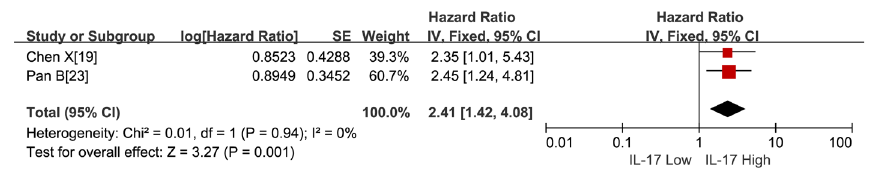
Fig 4. Meta-analysis comparing IL-17 expression and disease free survival (DFS) in lung cancer patients. The individualand pooledHR with 95% CI was shown by forest plot. HR > 1 impliedworse DFS for the group with high IL-17 expression.